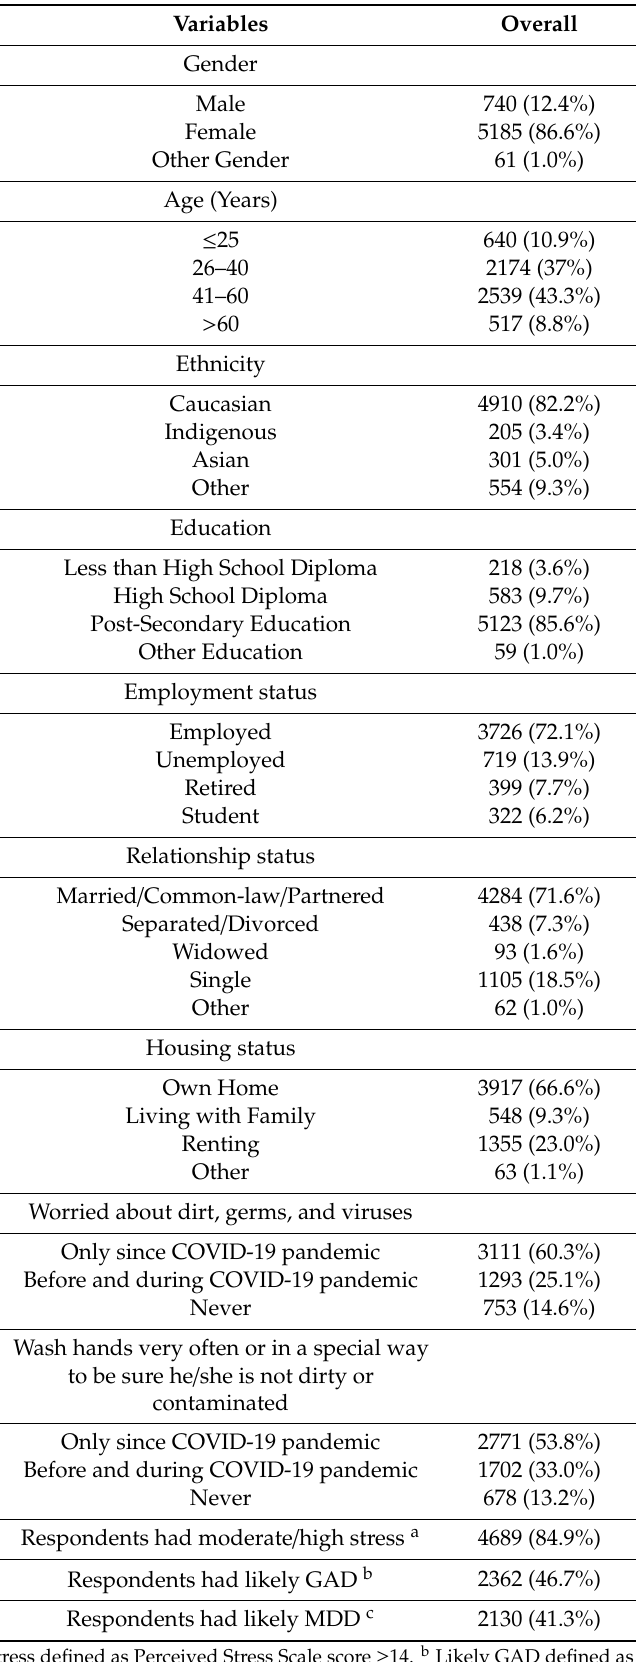
Table 1. Demographic and clinical characteristics of